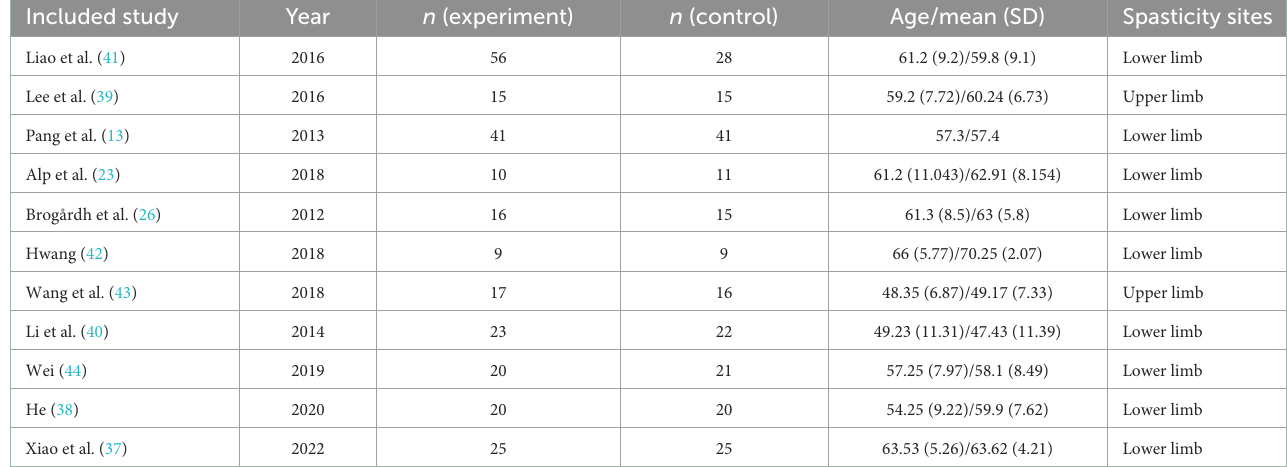
TABLE 1 General characteristics of the